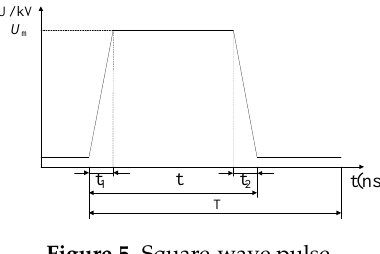
Figure 5. Square-wave pulse.